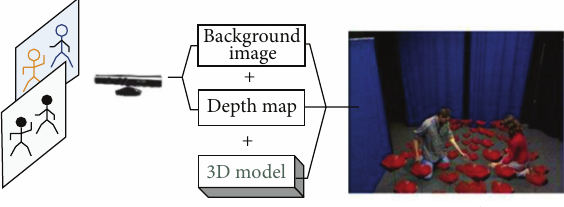
Figure 4: Integration of augmented reality and Kinect